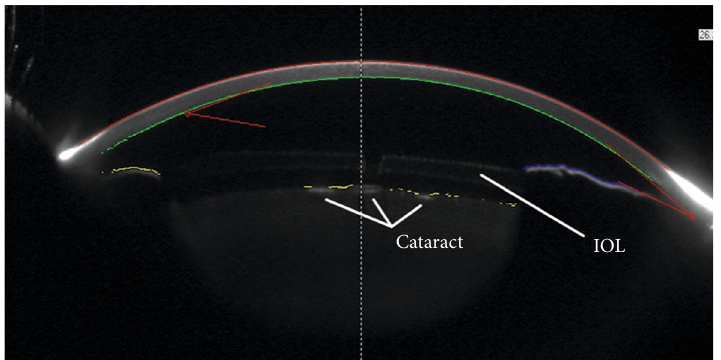
Figure 5: Anterior segment densitometry (Pentacam) demonstrating a correctly implanted intraocular lens (IOL) with a proper vault over the crystalline lens. Anterior subcapsular cataract can also be seen.